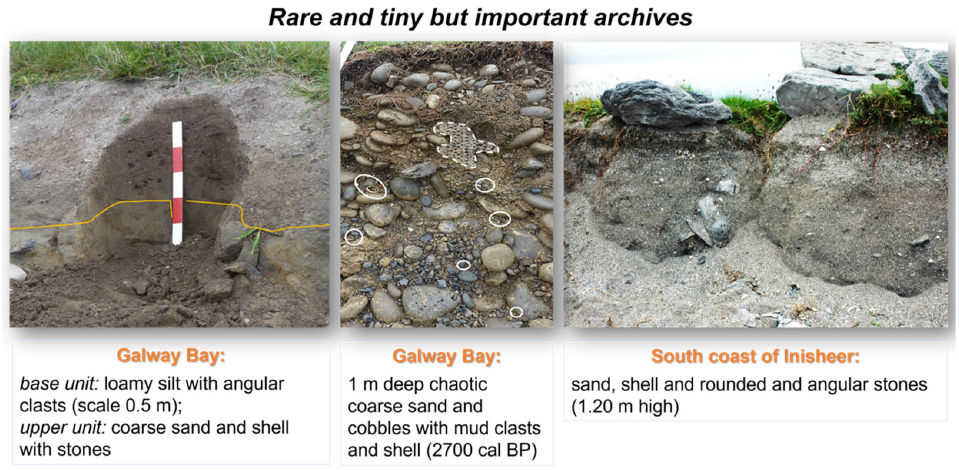
Figure 12. Chaotic (non-sorted) coastal deposits that are unusual in storm-wave dominated